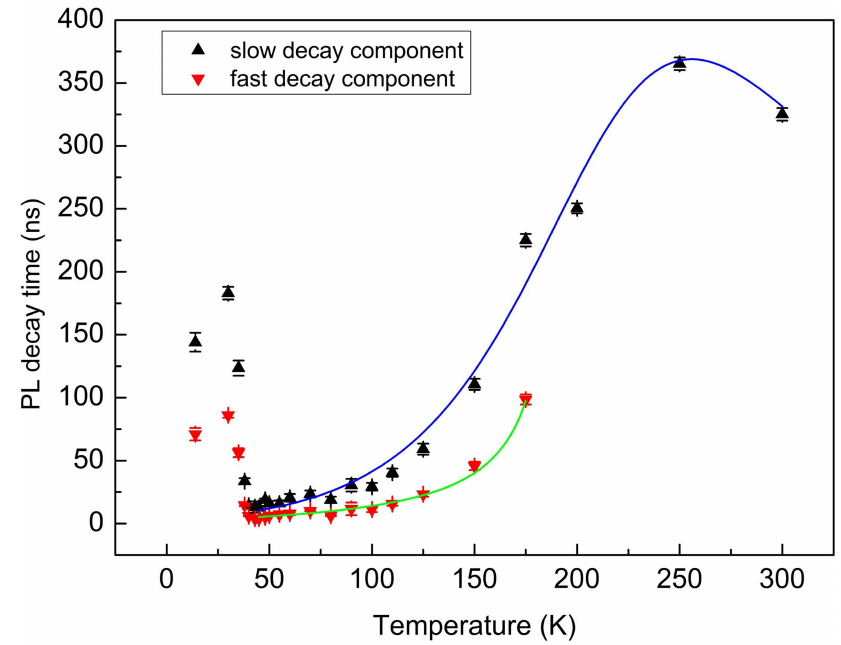
Figure 6. Temperature dependence of PL decay lifetimes of the AlGaInAs QW